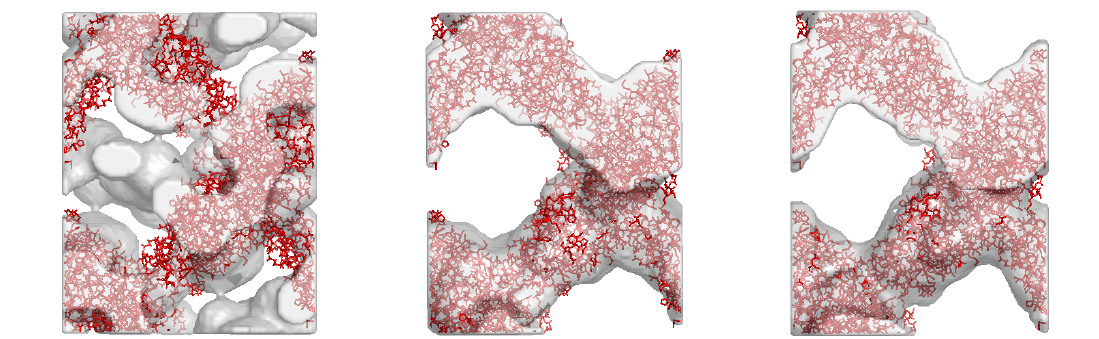
Figure 11. The reconstructed protein boundary at the 10th, 3000th, and 4000th iterations superimposed on the PDB